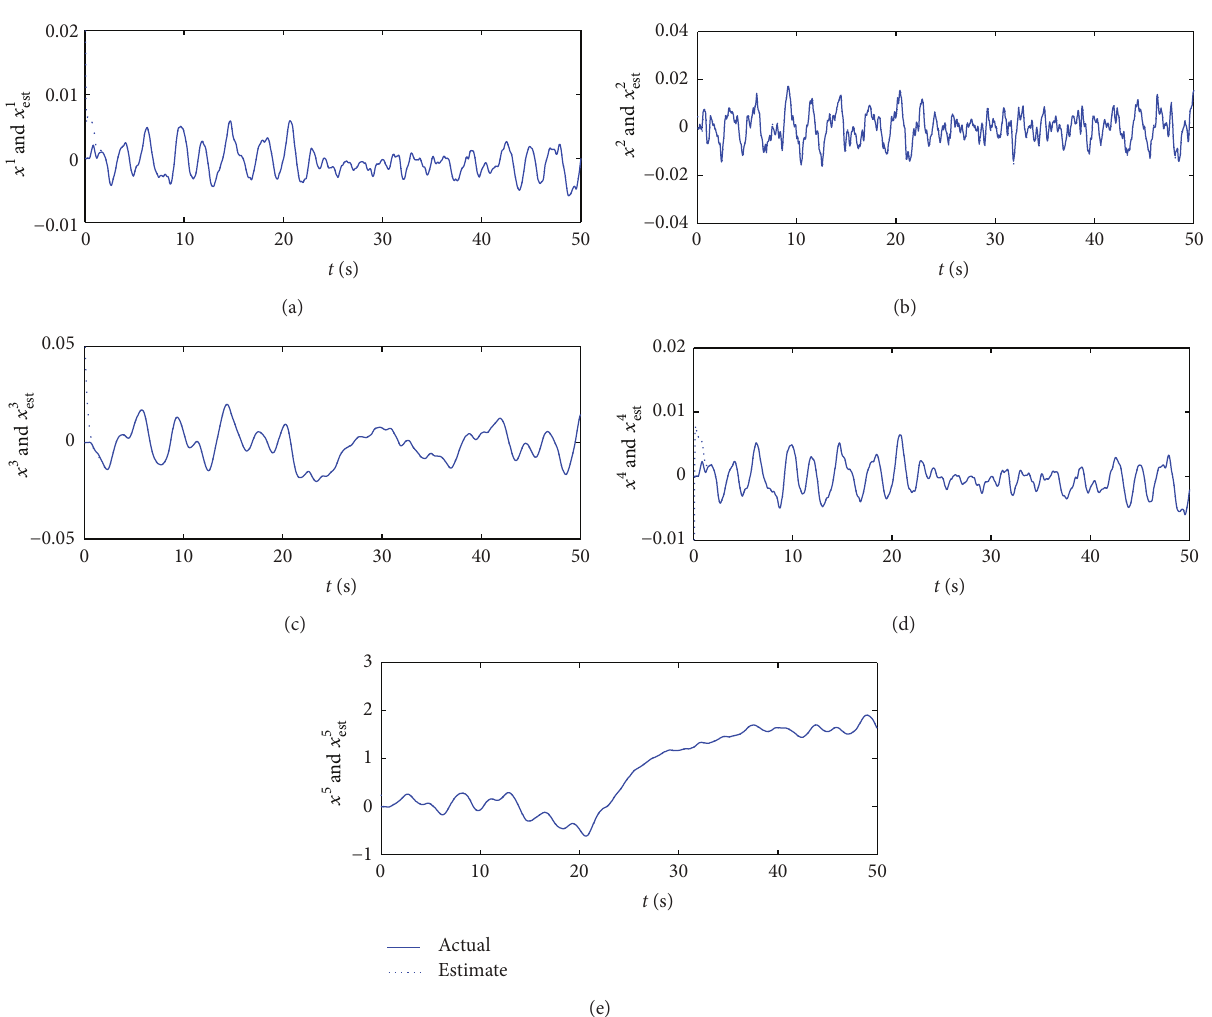
Figure 5: Actual state variables and estimations when 50% partial loss in stabilizer occurred at 20 seconds. Since actual and estimated state variables are too close, two curves are seen as one